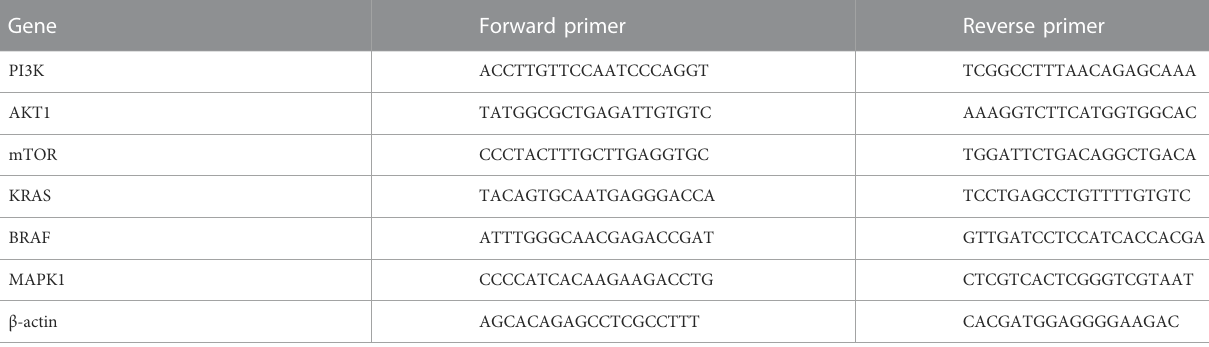
TABLE 1 List of primers ’ sequences used in the RT-qPCR experiments.